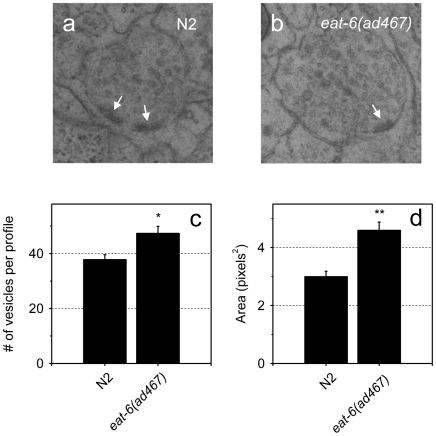
The eat-6(ad467) mutant accumulates more synaptic vesicles at ACh NMJs.(a) and (b) Representative synaptic profiles of WT and ad467 mutant worms obtained by high-pressure freezing EM. Arrows point to the active zone. (c) The average number of synaptic vesicles per profile and SEM, * p<0.005. (d) The average area of the synaptic profile and SEM. ** p<0.001. The data were collected from 24 and 23 synaptic profiles, respectively, in WT and ad467 worms. Four animals per each genotype were analyzed. Student's t-test.